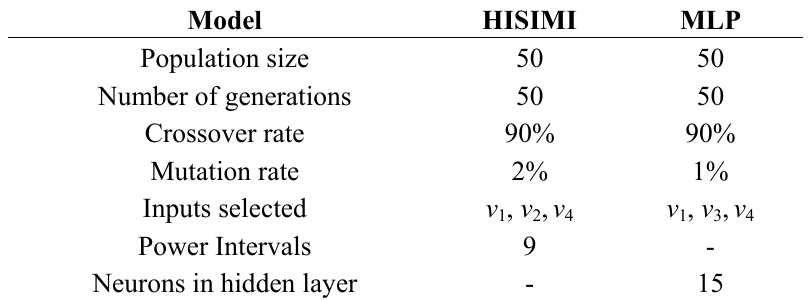
Table 3. Main parameters of the optimization of the HISIMI and MLP models.